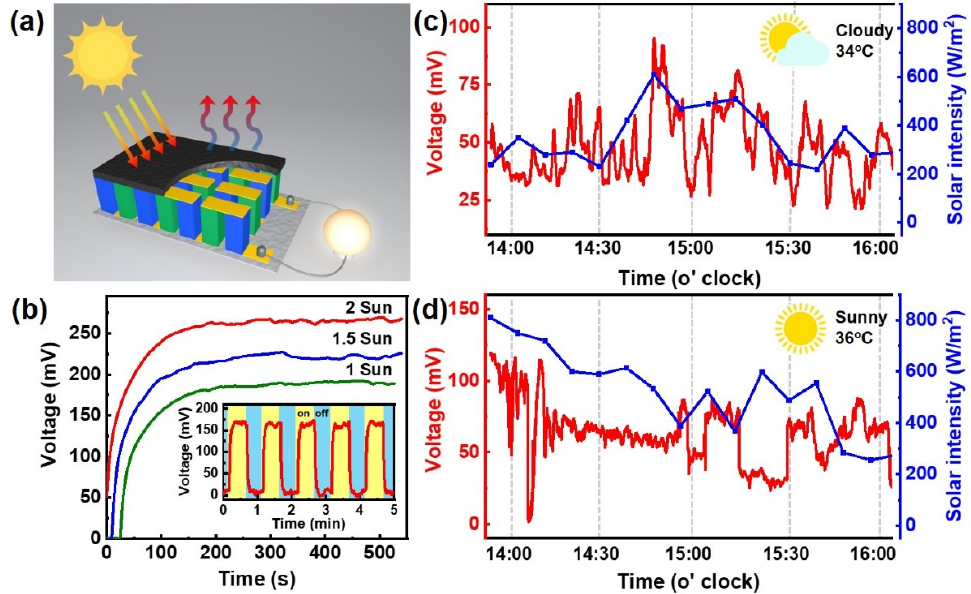
Figure 4. The output performance of the s-TEG. ( a ) Schematic illustration of s-TEG setup under sunlight. ( b ) The output performance of the s-TEG under different solar irradiation and the stability of on–off light illumination under one sun irradiation. The outdoor performance of the s-TEG in a typical ( c ) cloudy and ( d ) sunny day.